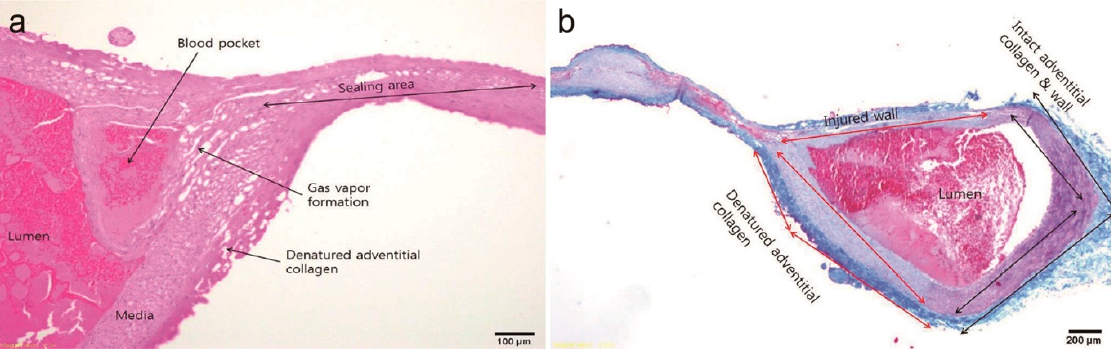
Figure 2. ( a ) Histological images of vessel sealing: Hematoxylin and eosin staining. ( b ) Histological images of vessel sealing: Masson’s trichrome staining.